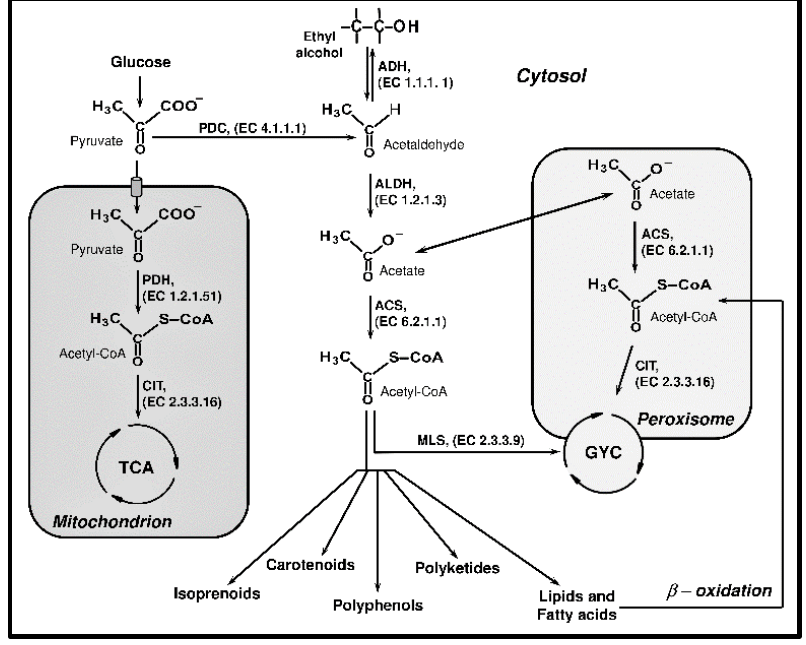
Figure 1. Metabolism of pyruvate and acetyl-CoA in Saccharomyces cerevisiae .